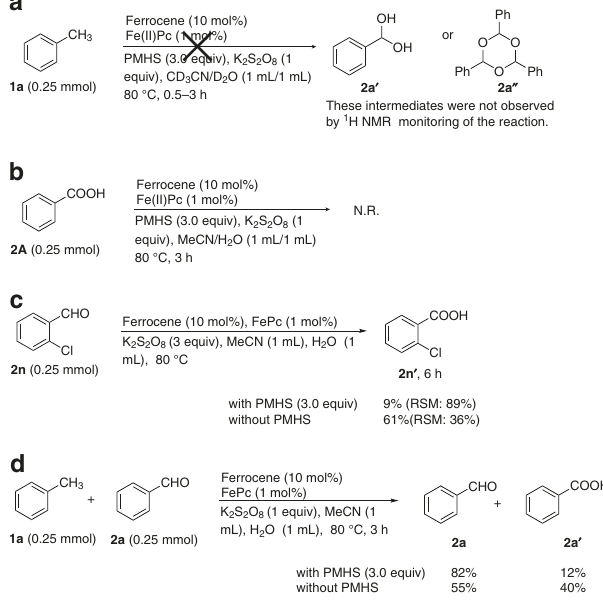
Fig. 7 Control experiments for probing the unique chemoselectivity for aldehydes. a 1 H NMR monitoring the potential intermediates of the model reaction. b The reaction using benzoic acid as a substrate. c The effect of PMHS on the oxidation of 2n ; RSM recovered starting material. d Competition experiments between toluene ( 1a ) and benzaldehyde ( 2a ) in the presence of K 2 S 2 O 8 and the iron catalyst with and without